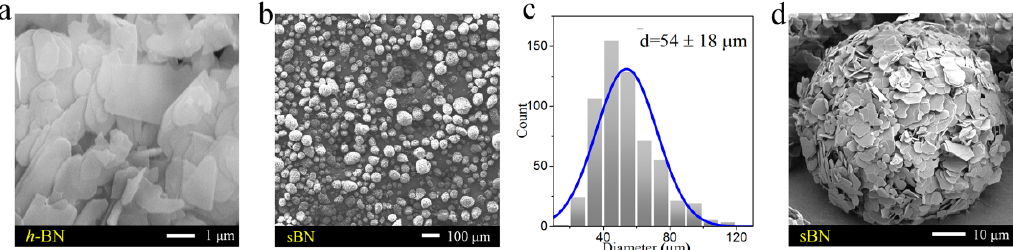
Figure 2. The morphology of BN. ( a ) SEM image of h- BN. ( b ) SEM image of spherical assembled h- BN (sBN). ( c ) Size statistic diagram of the sBN in ( b ). ( d ) SEM image showing that sBN consists of h- BN sheets.